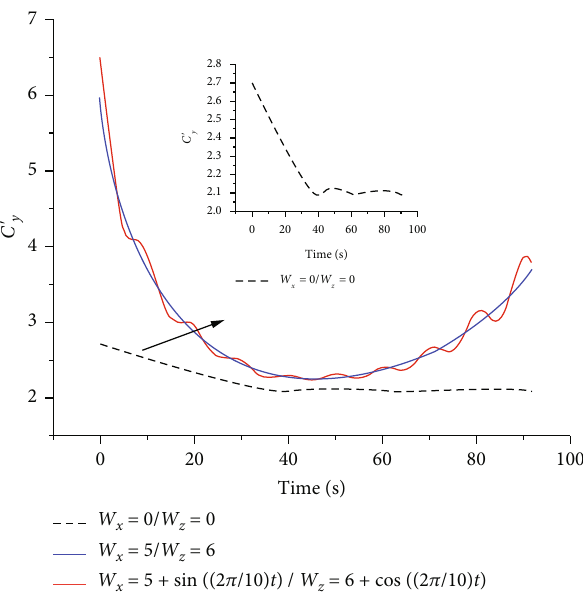
Figure 5: Variation curve of the derivative of the lift coe ffi cient under three conditions.